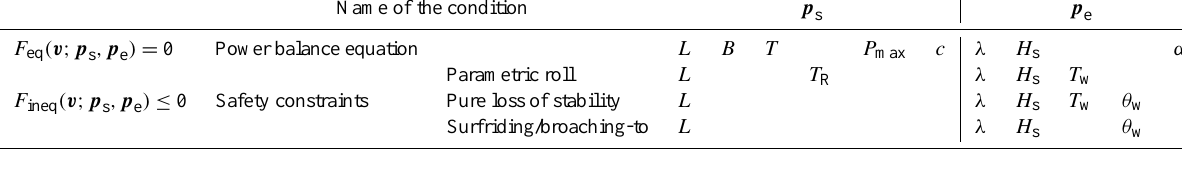
Table 6. Ship and environmental parameters ( p s and p e respectively) employed in the power balance equations Eqs. (4) and (14), and in the inequalities for the safety constraints Eq. (5). Derived parameters such as T E , g σ aw and e Fr are omitted. For an explanation of symbols; see Table 8.